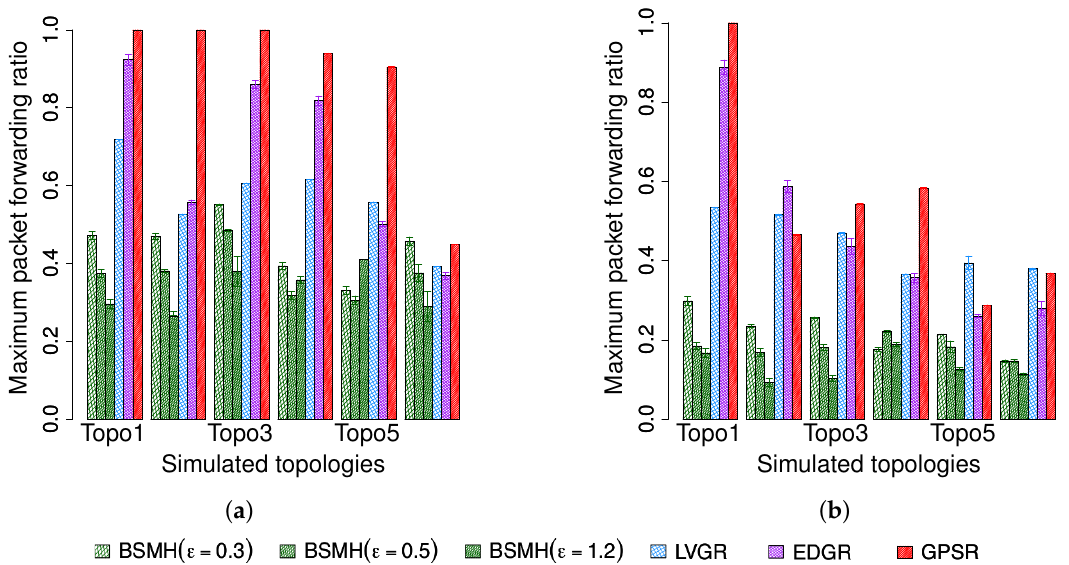
Figure 18. The maximum percentage of packets forwarded by a sensor node [38]. ( a ) 1-n communication. ( b ) n-n